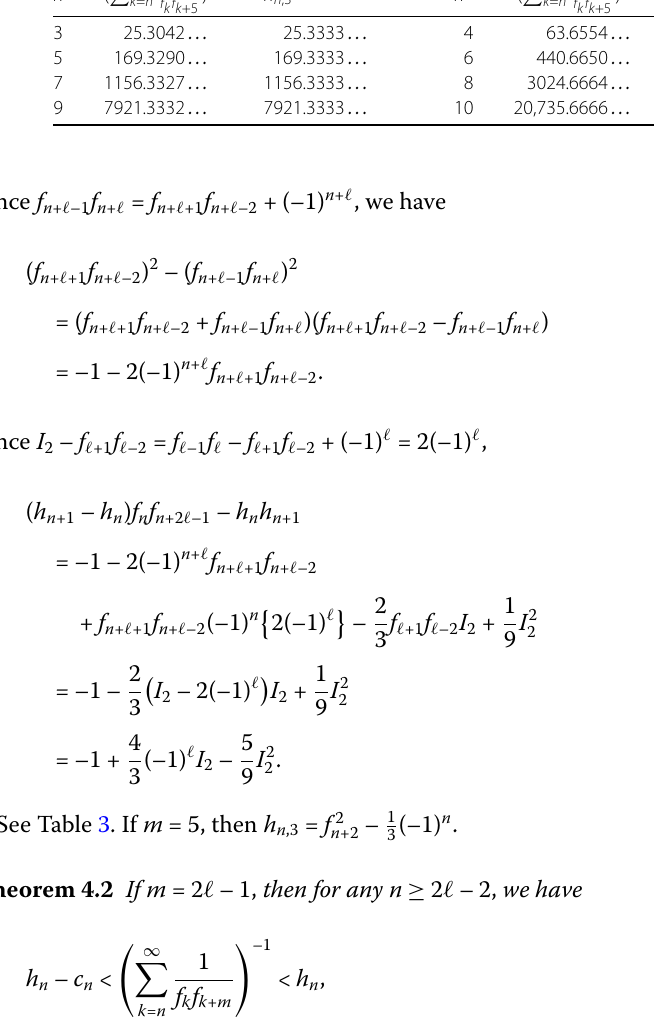
Table 3 Some values of (